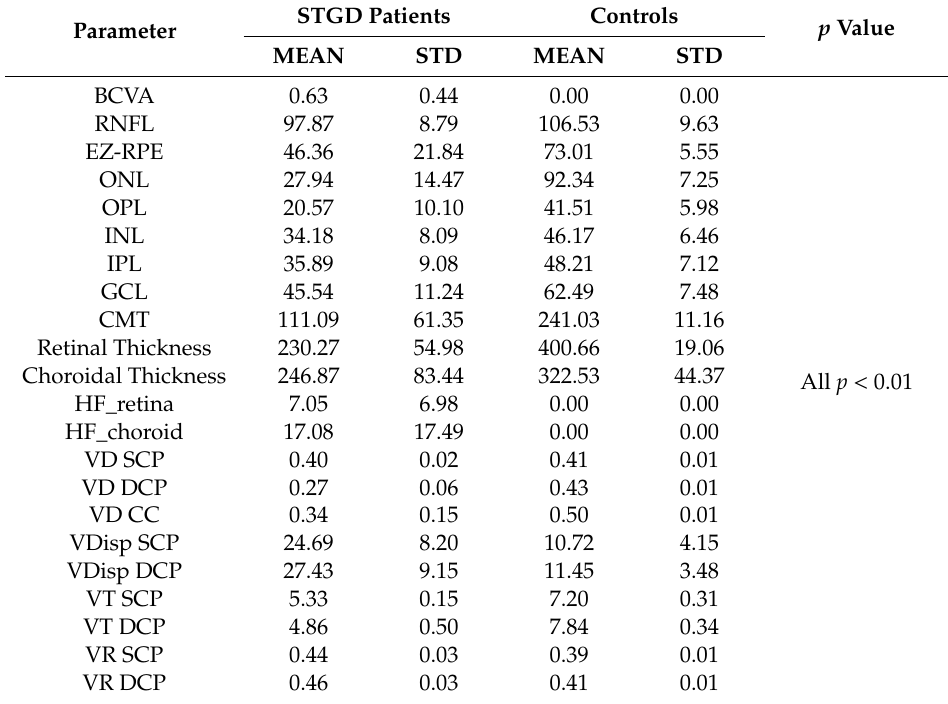
Table 1. Clinical and imaging